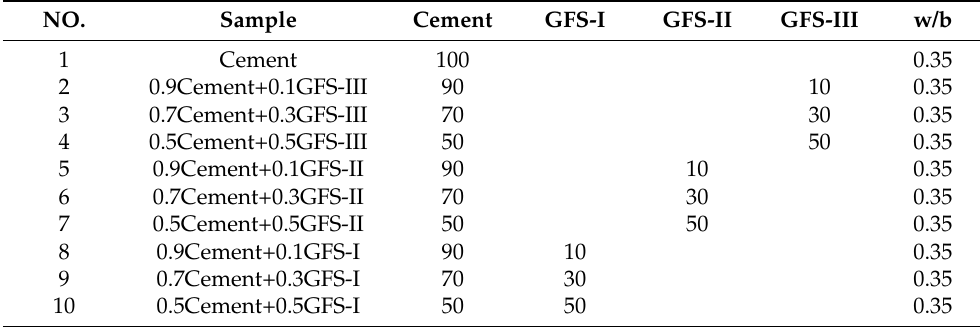
Table 2. The composition of cement and blended cement, expressed as a mix ratio in /%. NO.